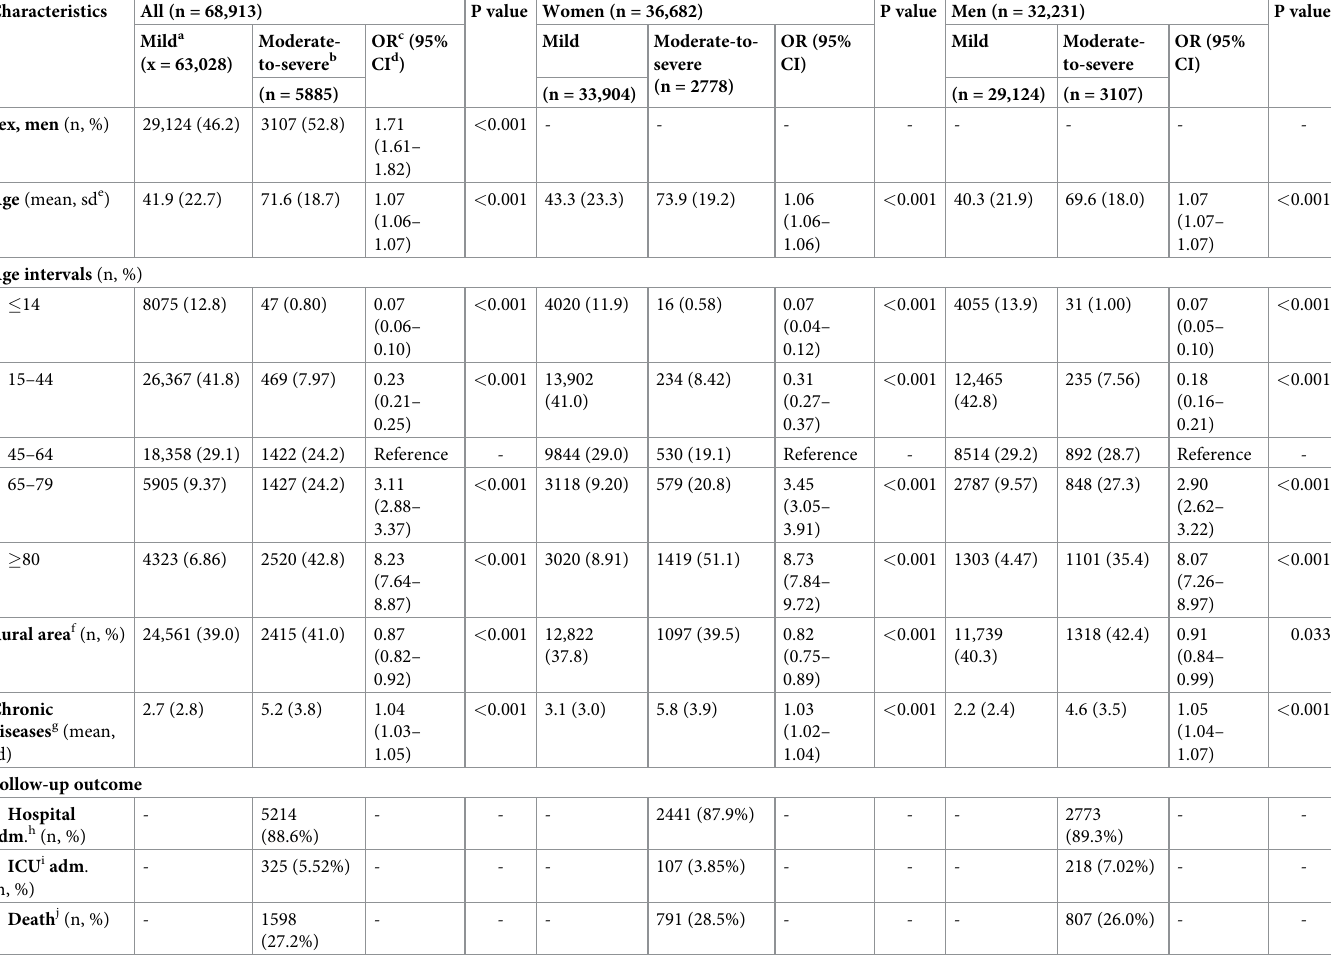
Table 1. Demographic and clinical characteristics of individuals with confirmed COVID-19 infection and effect on disease severity (defined as mild or moderate- to-severe according to hospital admission and mortality).